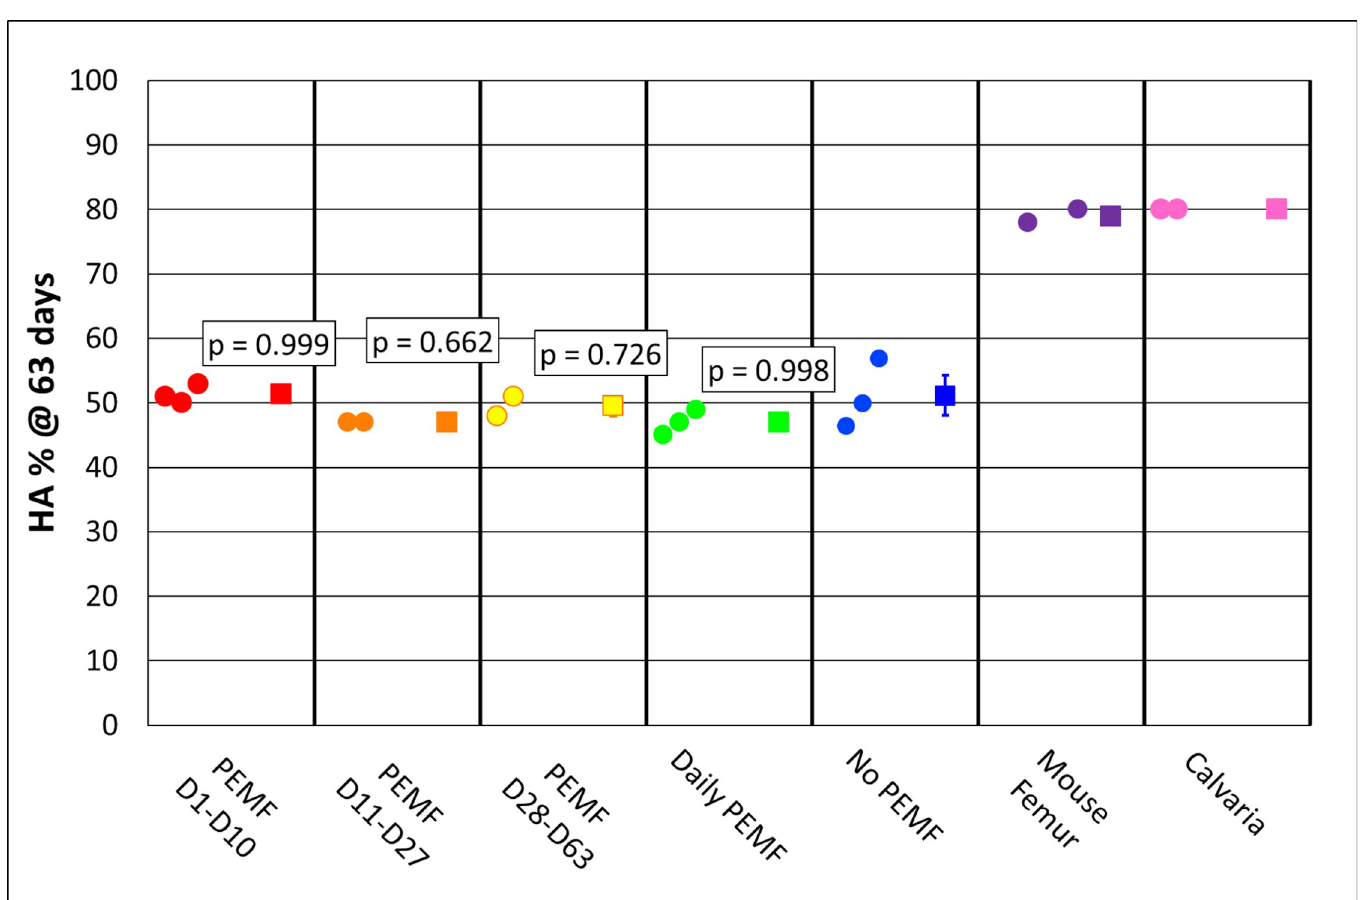
Fig 10. XRD analysis of HA content in PEMF-treated and control samples compared to calvaria and femur. Each group column presents individual values on the left, and the mean and standard error on the right if n is 3 or greater, p- value = Tukey HSD, alpha = 0.05.